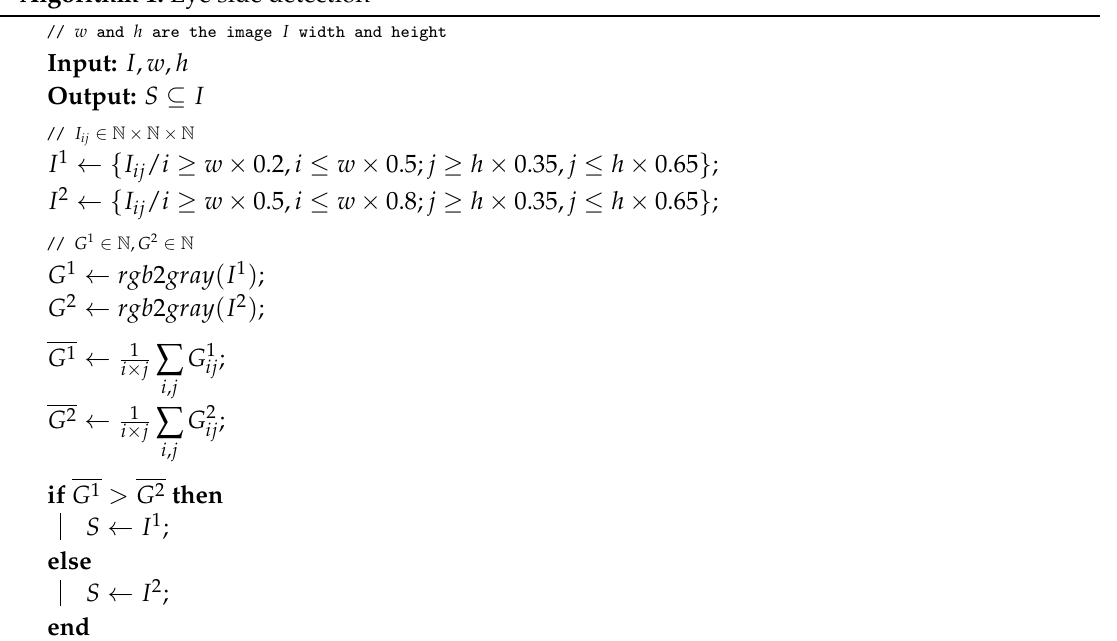
Algorithm 1: Eye side